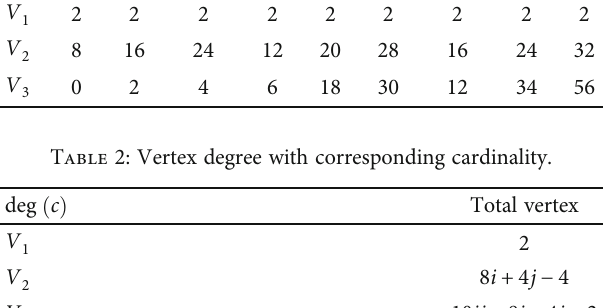
Table 1: Vertex partition of SiC